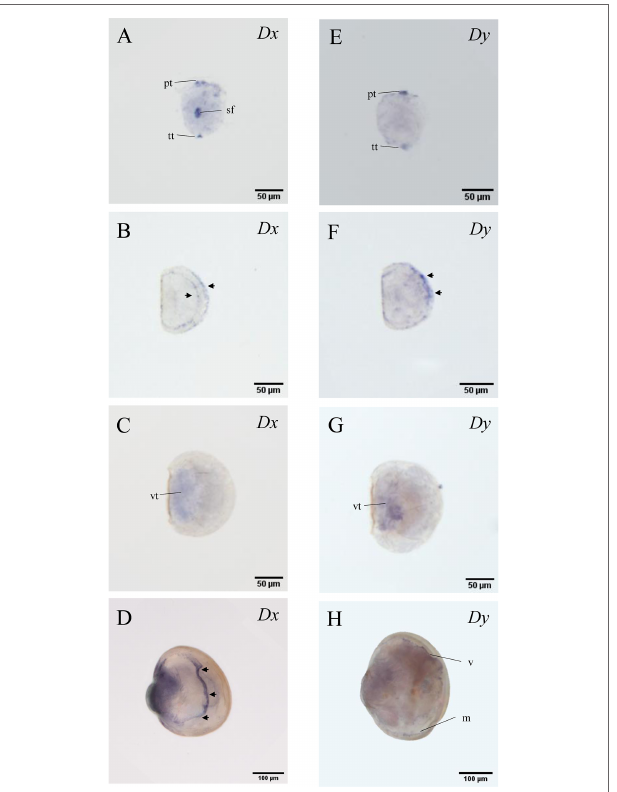
FIGURE 1 | McDx and McDy expression changes in four larval stages of M. coruscus . The apical pole is always upward and the ventral side is on the right except for A and E. (A, E) trochophore larvae (dorsal view); McDx and McDy signals in the prototroch and telotroch. McDx expressed in the shell field. (B, F) D-veliger larvae ; McDx and McDy signals are located at the edge of the shell (arrow). (C, G) umbo larvae; McDx and McDy expressed in the visceral tissues. (D, H) pediveliger larvae; McDx expressed in the medial region originating from the apical to the caudal region of the larva (arrow). McDy is expressed in the edge of the velum and mantle. pt, prototroch; tt, telotroch; sf, shell field; vt, visceral tissues; v, velum; m, mantel.